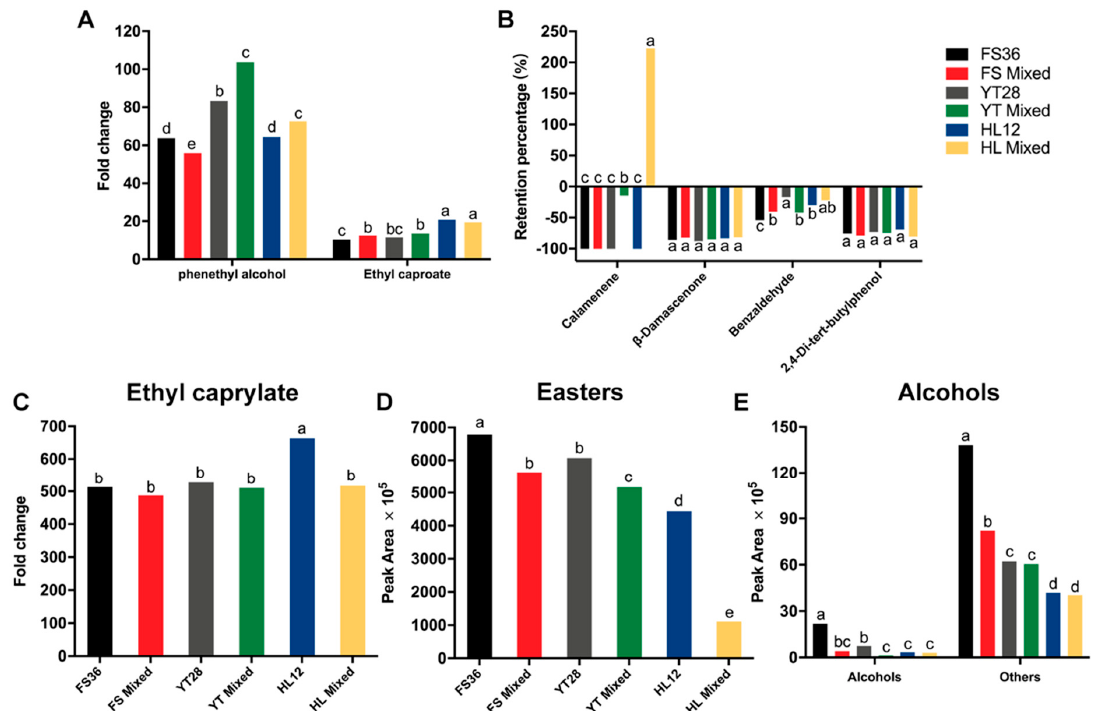
Figure 2. Changes of characteristic aromas in Marselan wine. Different letters indicate the significant differences at p < 0.05. ( A , C ) The fold change of phenethyl alcohol, ethyl caproate and ethyl caprylate in Marselan wines in comparison of must, respectively; ( B ) The retention percentage (%) of four varietal aromas in Marselan wines in comparison of must; ( D ) The peak area of easters of Marselan wines; ( E ) The peak area of alcohols of Marselan wines.